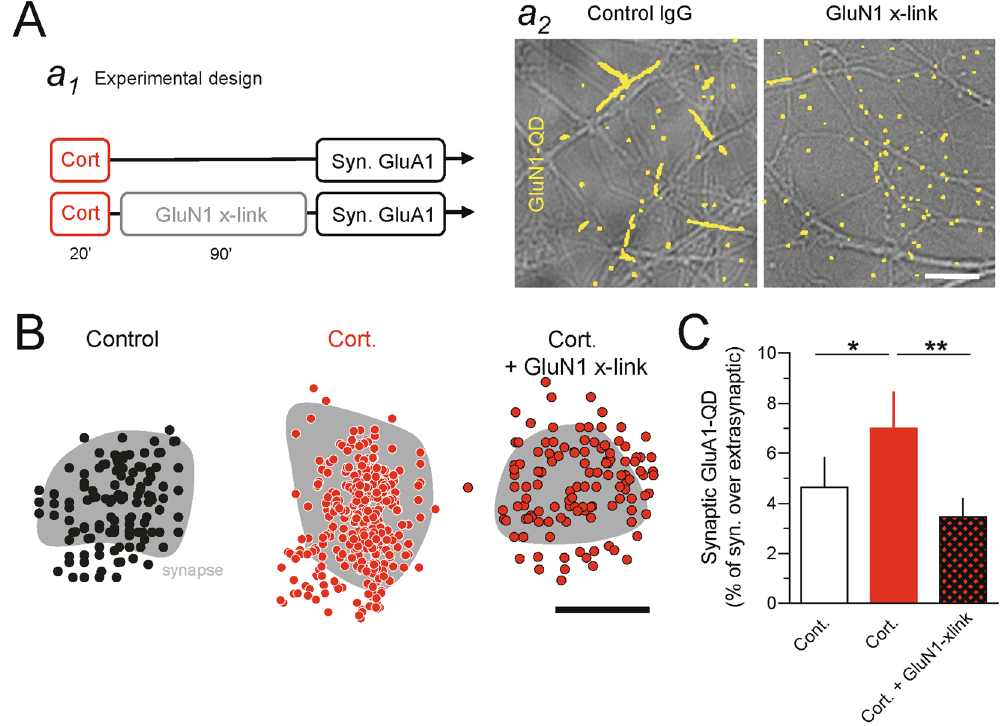
Figure 7. Corticosterone-induced AMPAR synaptic increase is prevented by surface NMDAR cross-linking (x-link). ( A ) Schematic representation of the experimental design ( a 1 ). Characteristic effect of GluN1 cross- linking on GluN1-NMDAR surface diffusion. Note the strong reduction in trajectory lengths in GluN1 x-link (20 min exposure) when compared to the control IgG condition ( a 2 ). Scale bar, 4 µ m. ( B ) Representative distributions of GluA1-AMPAR within synapses exposed to corticosterone alone or corticosterone plus GluN1 x-link. Scale bar, 500 nm. ( C ) Comparison of the percent of synaptic GluA1-AMPAR over the extrasynaptic ones between conditions (control, n = 26 dendritic fields; corticoterone, n = 28 dendritic fields; corticosterone + GluN1 x-link, n = 32 dendritic fields; N > 7 neurons for each condition). * p < 0.05, ** p < 0.01, One-way ANOVA followed by a Newman-Keuls multiple comparison